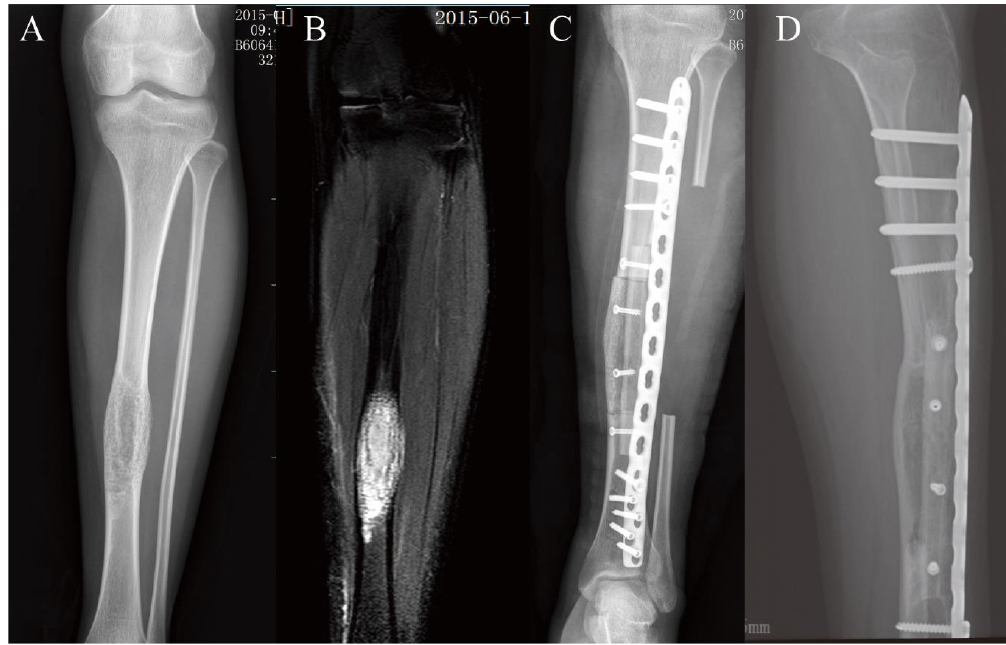
Figure 4. A patient received biological reconstruction in the left tibia. ( A , B ) A female patient, aged 19 years, was histologically diagnosed with adamantinoma. The tumor was assessed by both X-ray and magnetic resonance imaging. ( C ) Photograph showing reconstruction with the fibular graft inserted into the medullary canal of the autograft and fixation with a single plate. ( D ) Radiograph showing primary union five months after surgery.